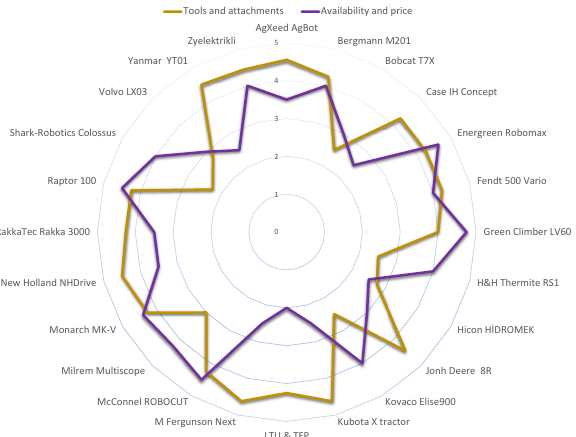
Figure 10. MIM overall evaluation: control, perception and communications KPIs.